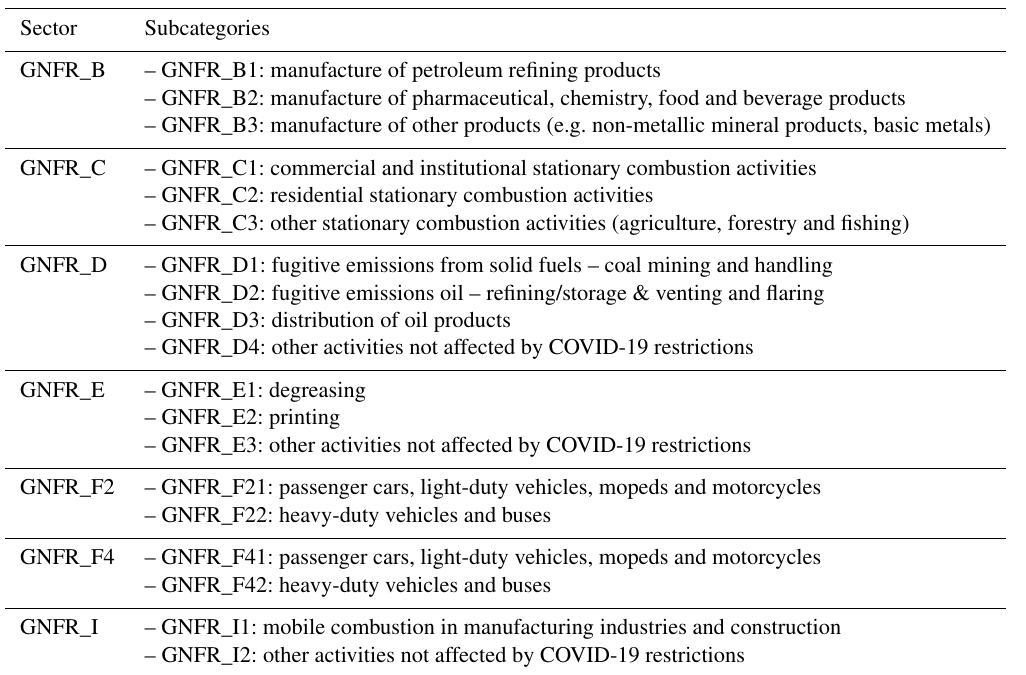
Table 2. Subcategories considered for the development of the adjustment factors for each GNFR